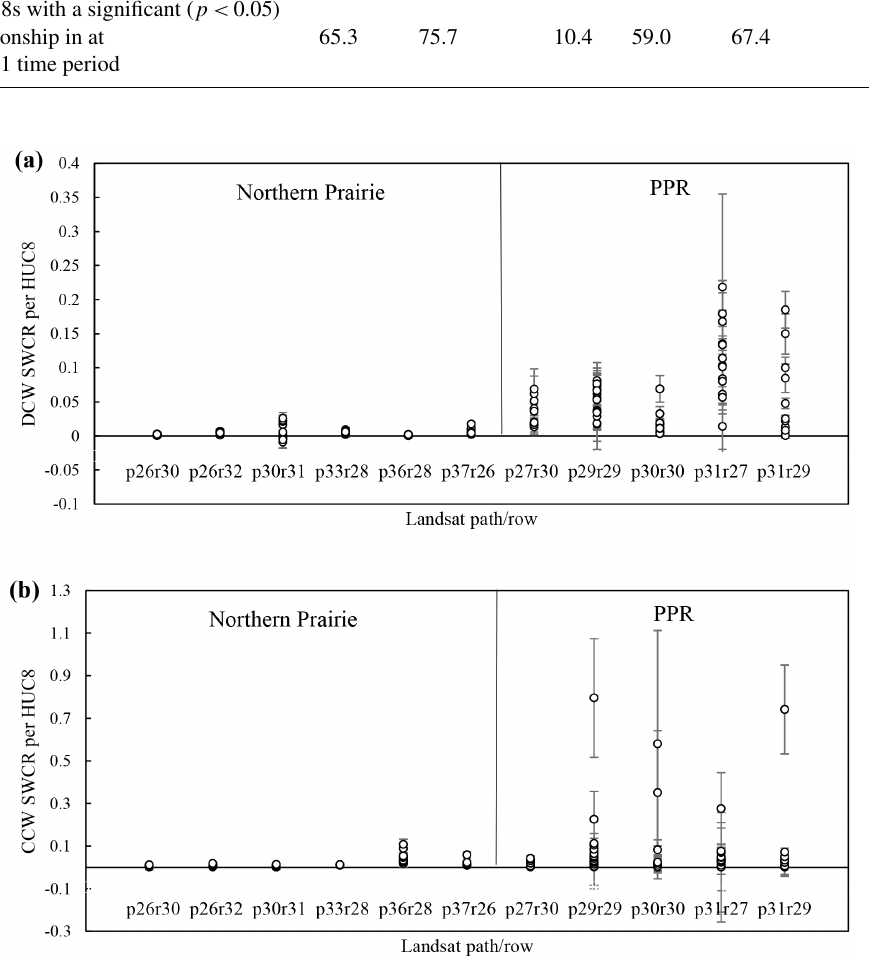
Figure 7. Distribution of Surface Water Climate Response and standard error values organized by Landsat path/row and primary path/row location, i.e., the Northern Prairie or the Prairie Pothole Region (PPR) for (a) surface water that is disconnected from the stream net- work (DCW), and (b) surface water that is connected to the stream network (CCW). HUC8 – eight-digit Hydrological